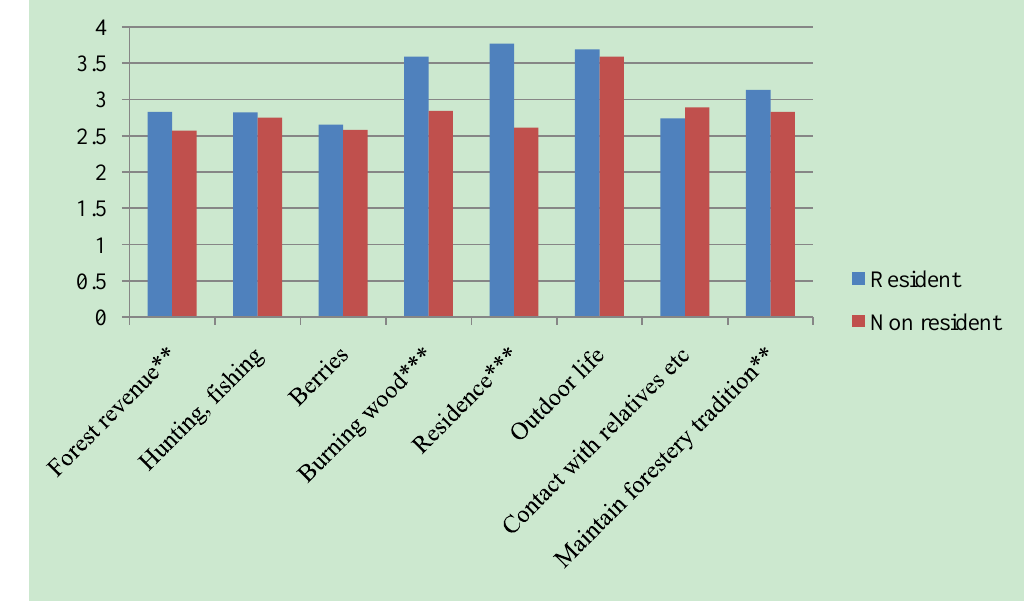
Figure 2. Importance of different aspects/utilities of forest ownership. *** p < 0.001, ** p < 0.01, * p <